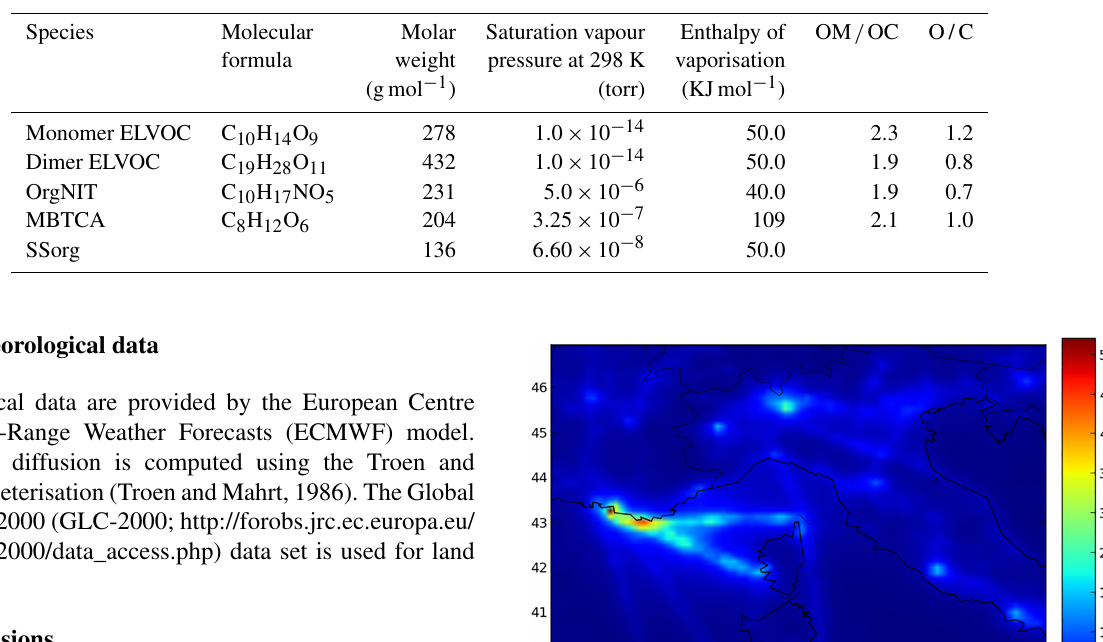
Table 3. Species introduced in the extremely low-volatility organic compounds (ELVOC), organic nitrate (orgNIT) and MBTCA kinetic models.